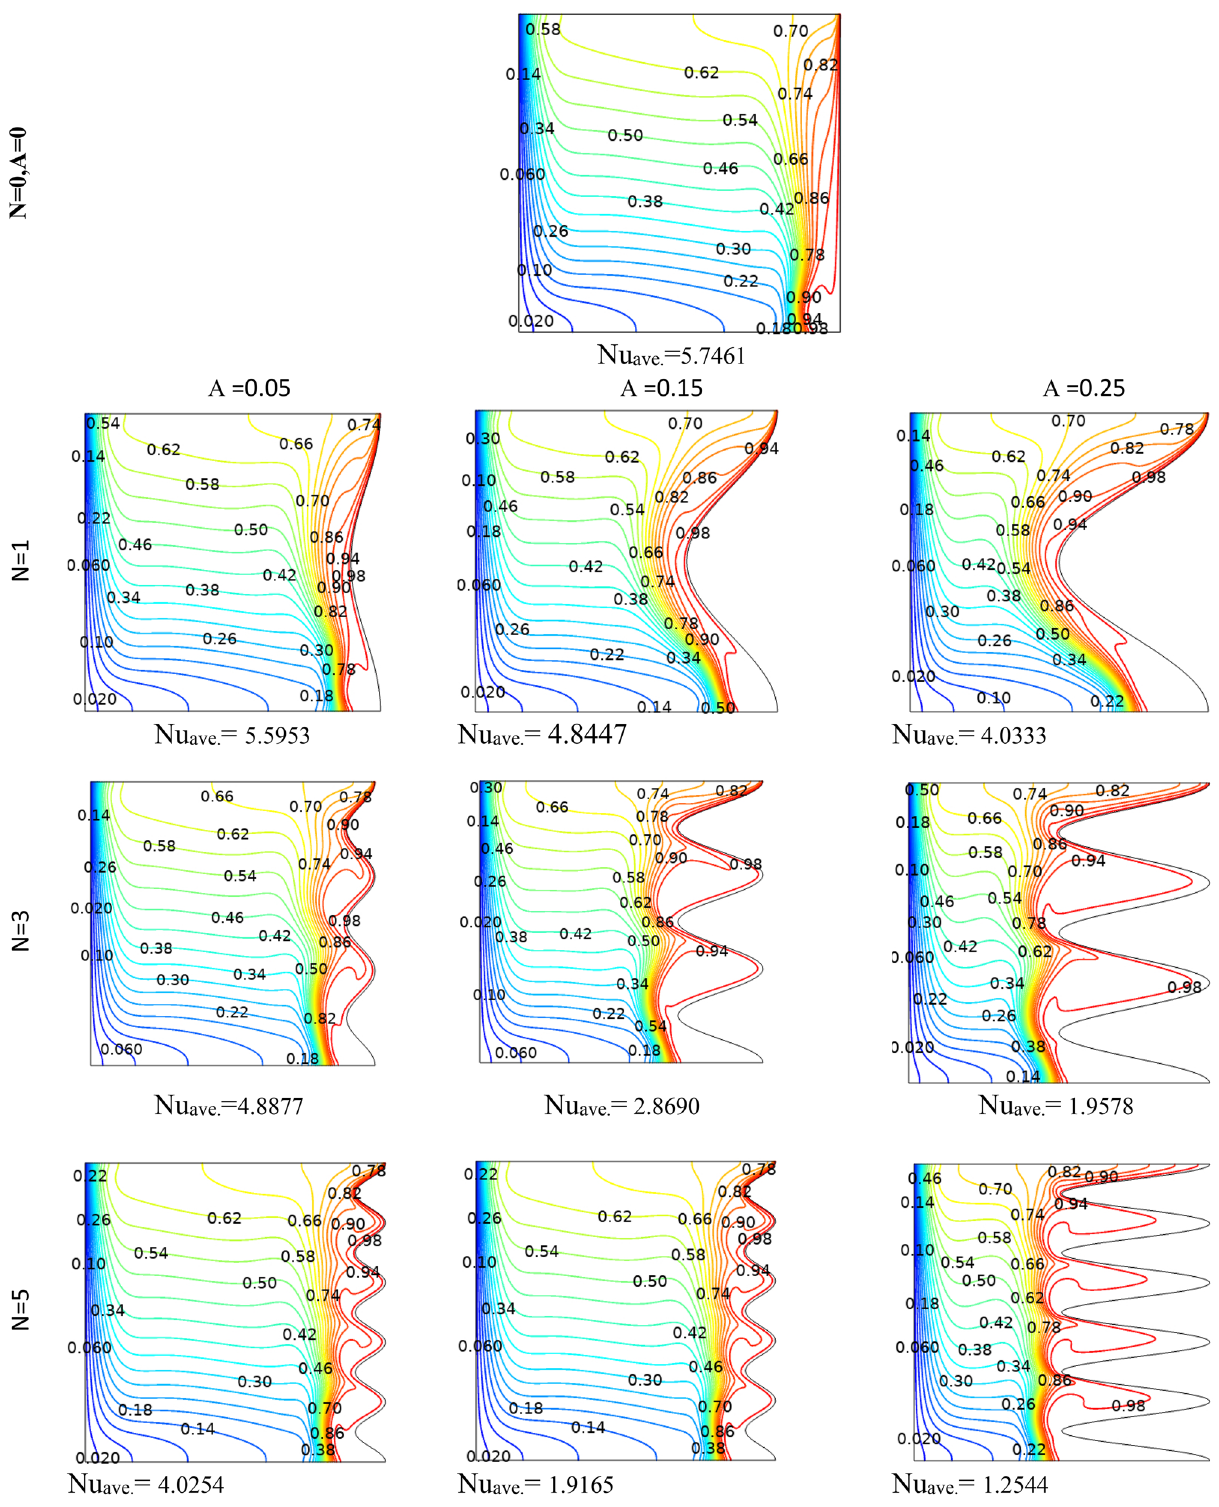
Figure 13. Streamlines and isotherms at (Da = 1e−3, Re = 200, λ = 5, φ = 0.03, Ha = 25, γ = 45, Ri = 10) for Case